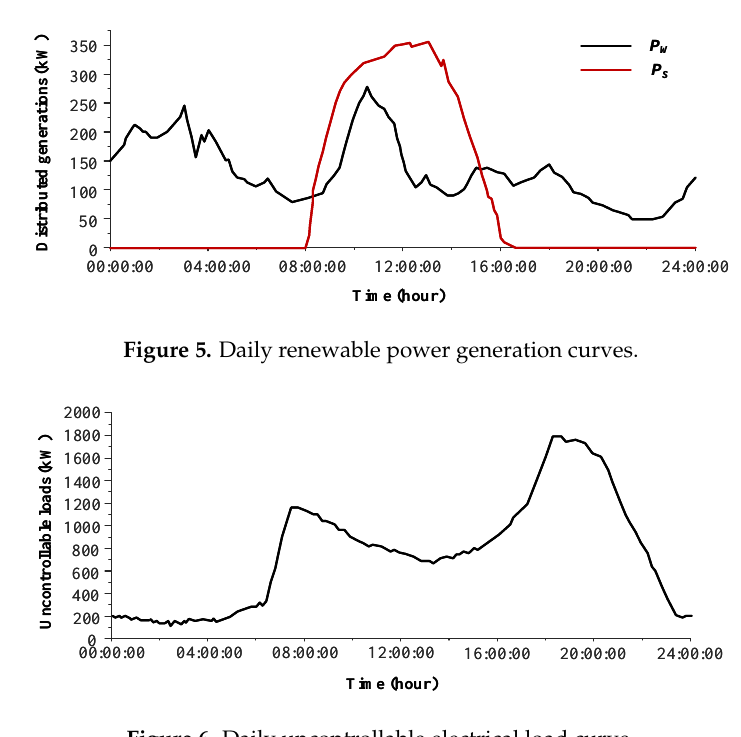
Figure 6. Daily uncontrollable electrical load curve.